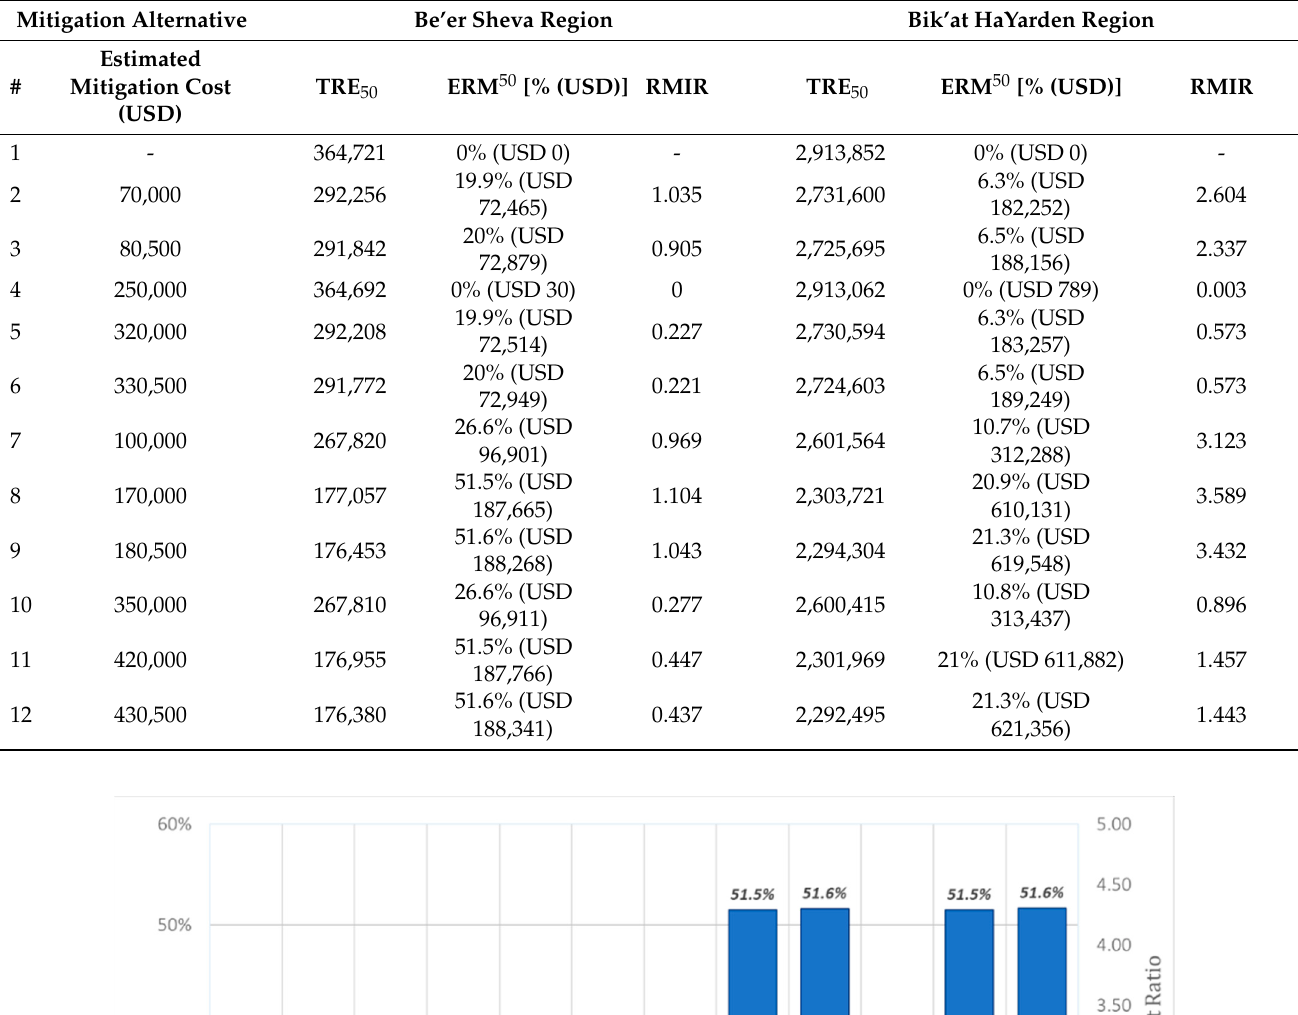
Table 2. Total risk expectancy for 50-year designed life cycle (TRE 50 ), estimated risk mitigation (ERM 50 ), and calculated RMIR for different mitigation alternatives.